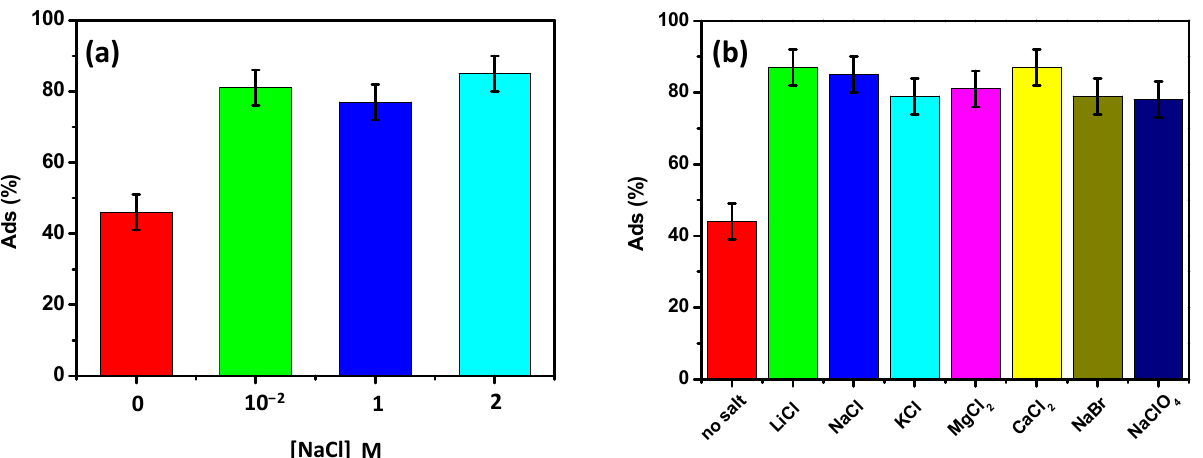
Figure 5. Adsorption capacities of β -EPI (6.3 g/L) at the equilibrium in 5 mg/L CBZ aqueous solutions ( a ) at different NaCl concentrations and ( b ) in the presence of different inorganic salts at 2 M concentration.